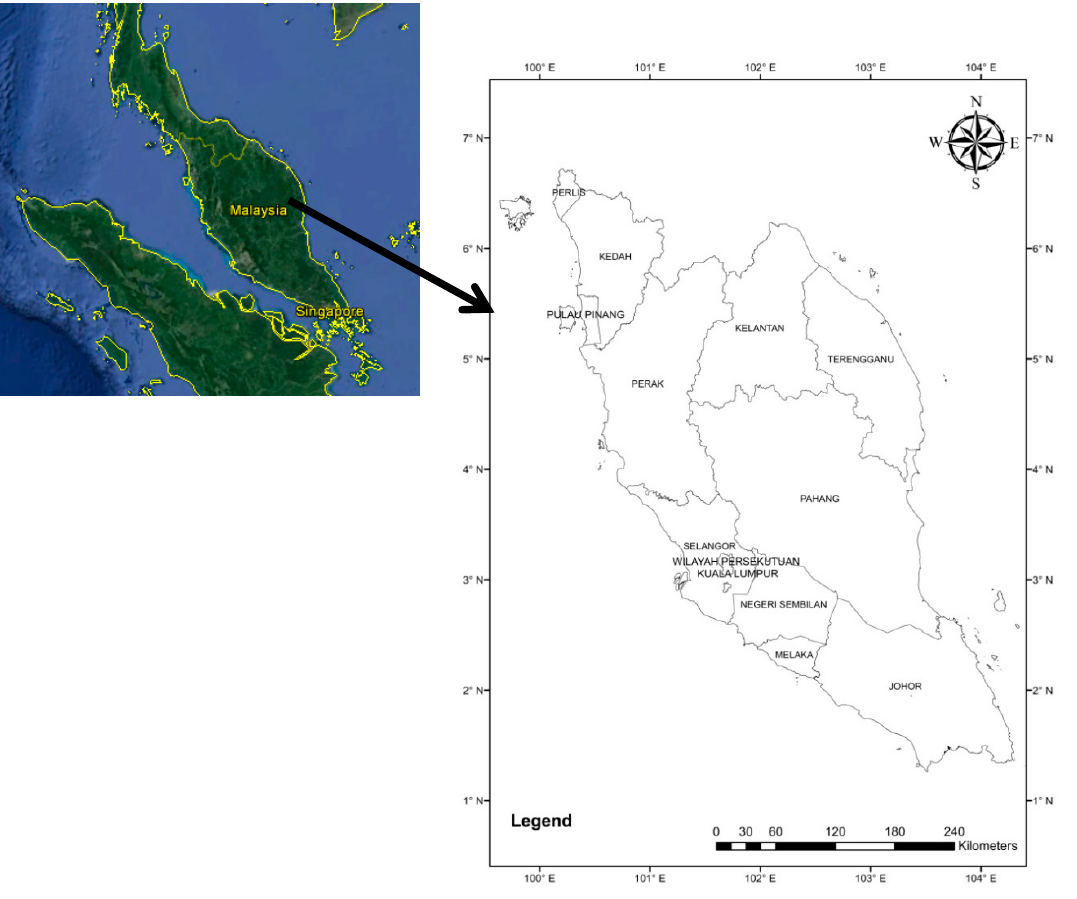
Figure 1. Maps showing the location of the study region. Source Figure (left): Google Earth image .